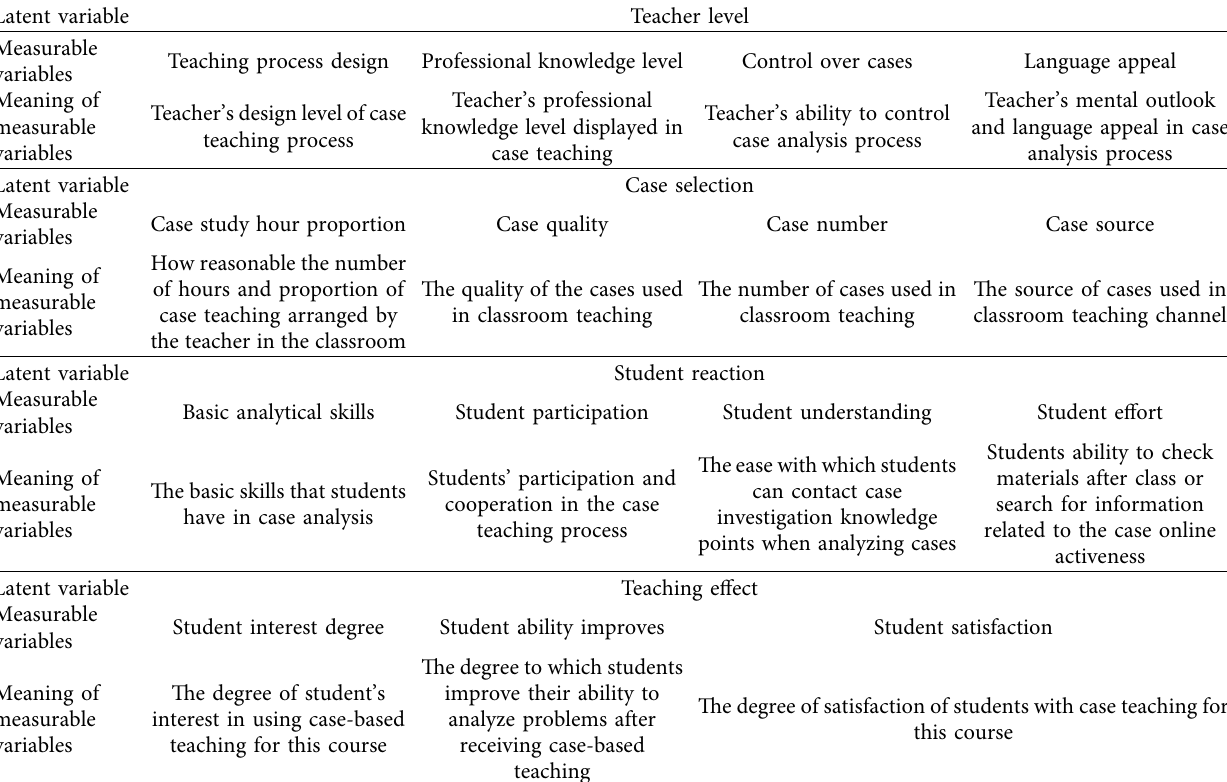
Table 1: Correspondence table of latent variables, measurable variables, and their meanings.